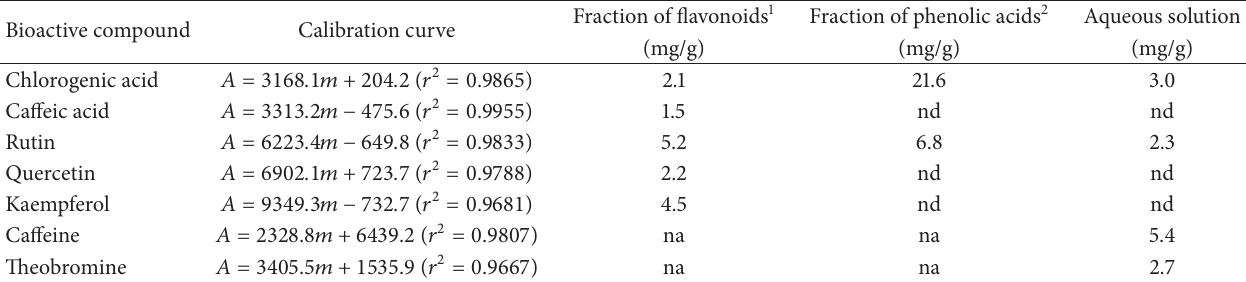
Table 2: Results of quantification of individual flavonoids, phenolic acids, and xanthines.